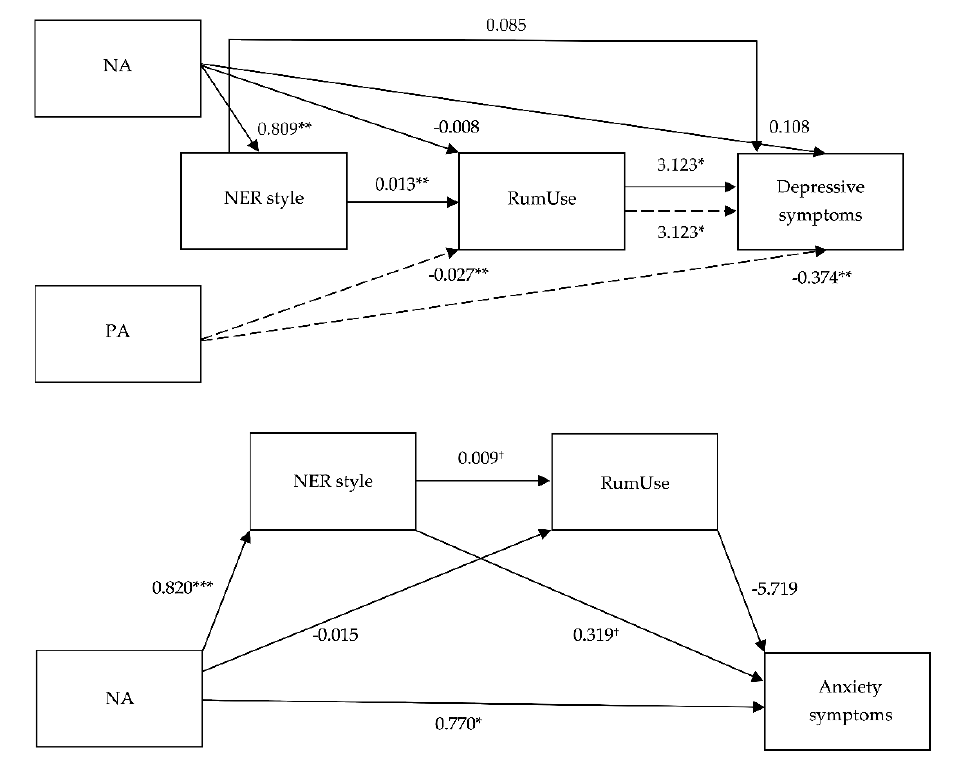
Figure 2. Path diagram depicting all direct paths in the mediation models, with negative a ff ect (NA) and positive a ff ect (PA) as predictors, negative emotion regulation (NER) style and the use of rumination (RumUse) specified as mediators, and depressive symptoms (upper) and anxiety symptoms (lower) as the outcome. All numbers indicate unstandardized path coe ffi cients. † indicates p < 0.10, * indicates p < 0.05, ** indicates p < 0.01, *** indicates p < 0.001. Table 4. Bootstrapped indirect e ff ects of adolescent a ff ect on depressive and anxious symptoms through mediators.